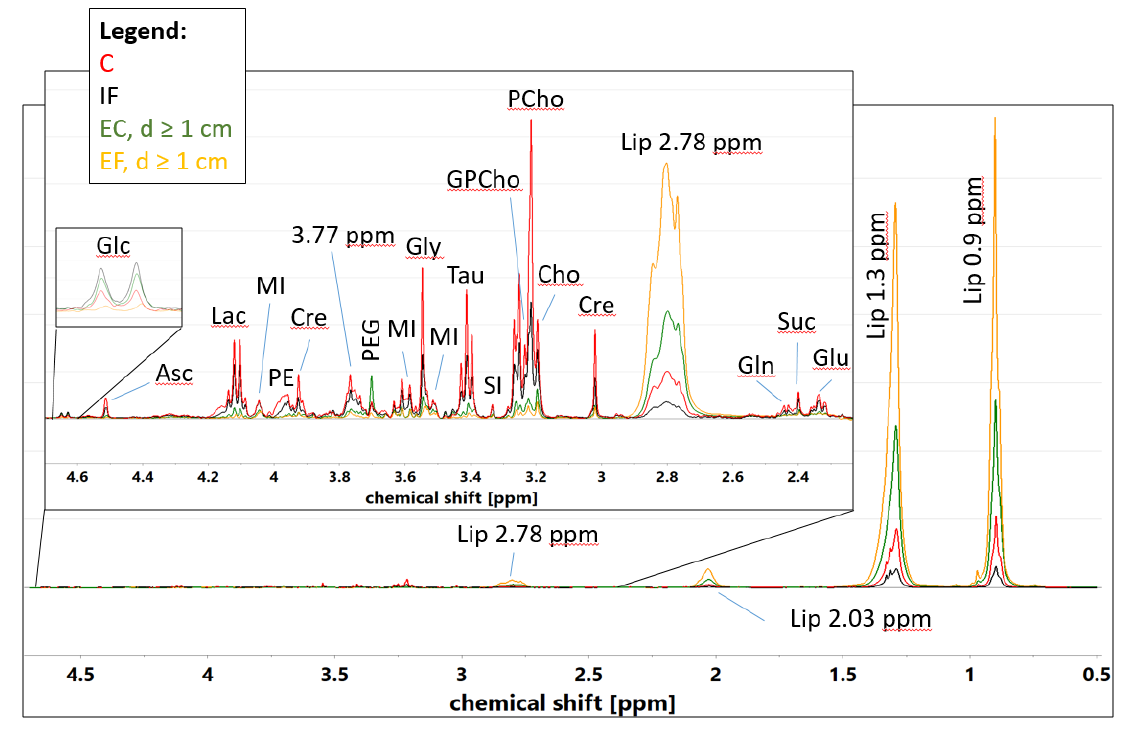
Figure 2. The average 1 H CPMG HR-MAS NMR spectra calculated for the samples representative of cancer (C), intratumoral fibrosis (IF), extratumoral fatty tissue (EF, d ≥ 1 cm) and extratumoral fibrous connective tissue (EC, d ≥ 1 cm). The assigned low-molecular-weight signals: Glc – glucose,